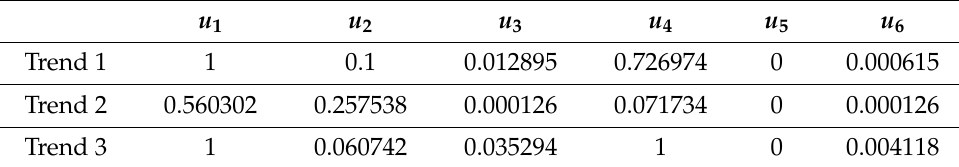
Table 3. Elements of the Universe vs Trends.